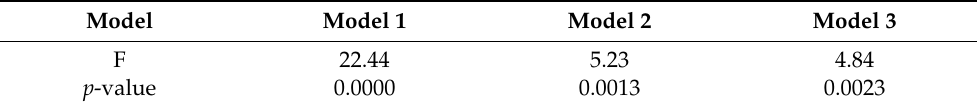
Table A3. Ramsey RESET test.